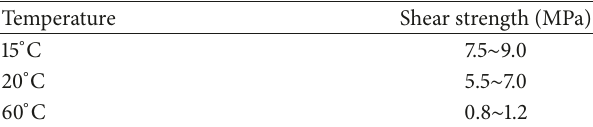
Table 9: Common values of shear